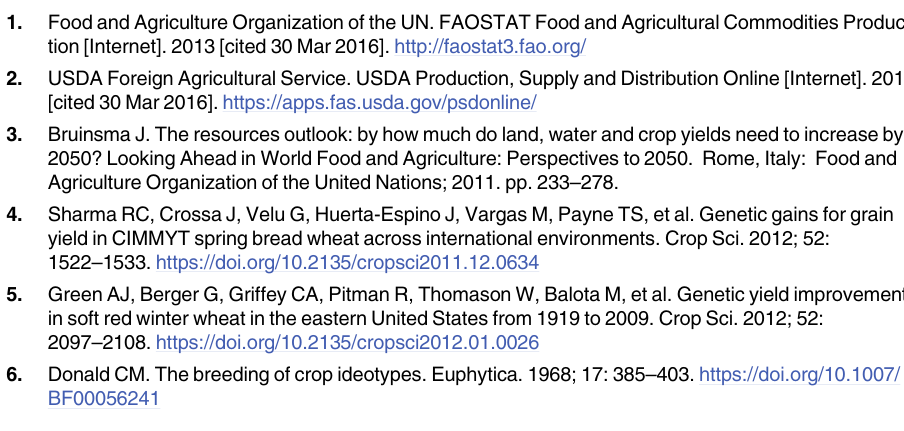
S1 Fig. Individual and cumulative portions of variance explained by the first 25 principal components of the imputed genotypic data, prior to LD-based filtering. (TIFF) S2 Fig. Number of SNPs per chromosome following the application of all genotypic data filtering steps. (TIFF) S1 File. Manhattan and QQ plots for SNP p-values generated by the GCTA leave-one-chro- mosome-out (LOCO) mixed linear model GWAS. (PDF) S2 File. Manhattan and QQ plots for SNP p-values generated by the FarmCPU